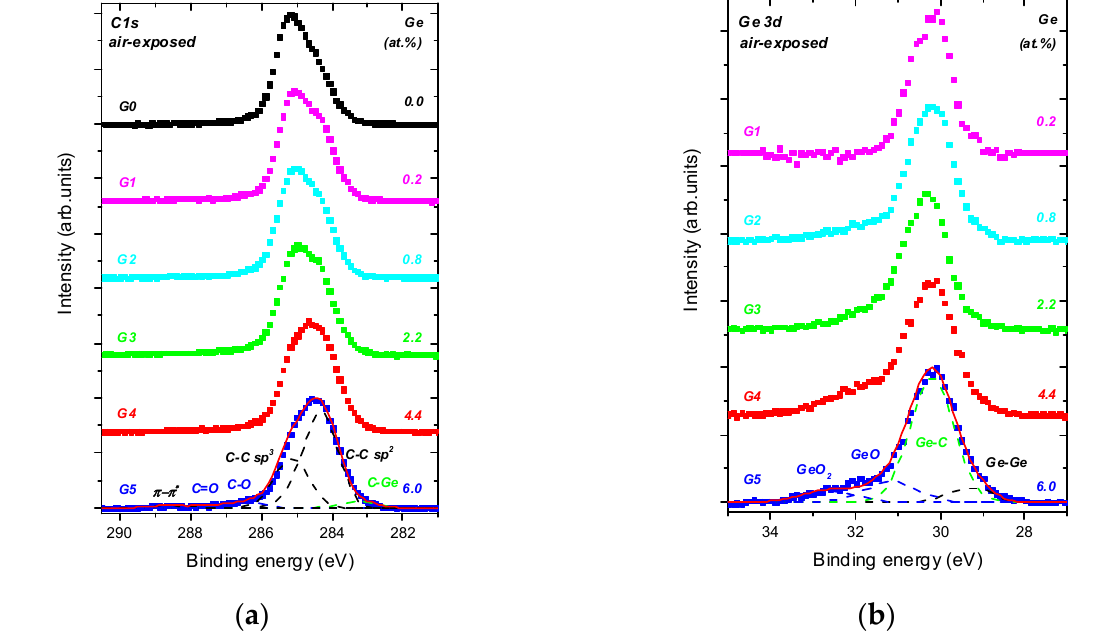
Figure 2. Exemplary high-energy resolved C 1s ( a ) and Ge 3d ( b ) spectra recorded from undoped and Ge-doped DLC layers at the normal emission angle, normalized to unity. Peak-fits of the resolved bonding states are illustrated.